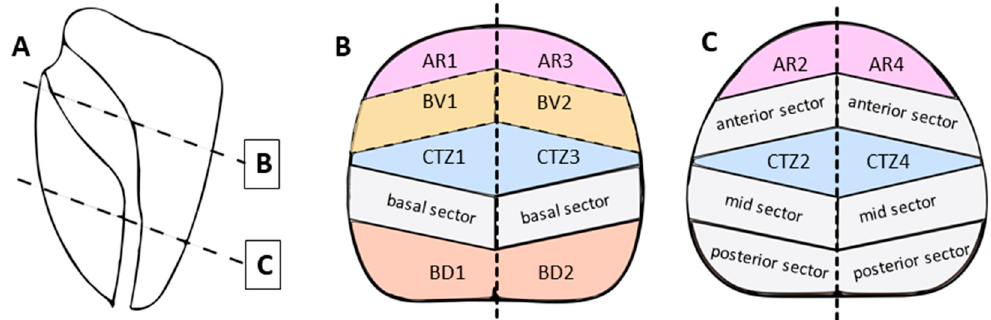
Figure 3. New sector map of the prostate. A Sagittal section of the prostate with indication of transversal planes for B and C . Ginsburg sectors are marked in grey color and nomenclature is in accordance with the pre-established GBS. Four blind sectors are added: anterior region AR1–AR4 (pink), central transition zone CTZ1–CTZ4 (blue), basoventral sector BV1 and BV2 (yellow), and basodorsal sector BD1 and BD2 (orange).